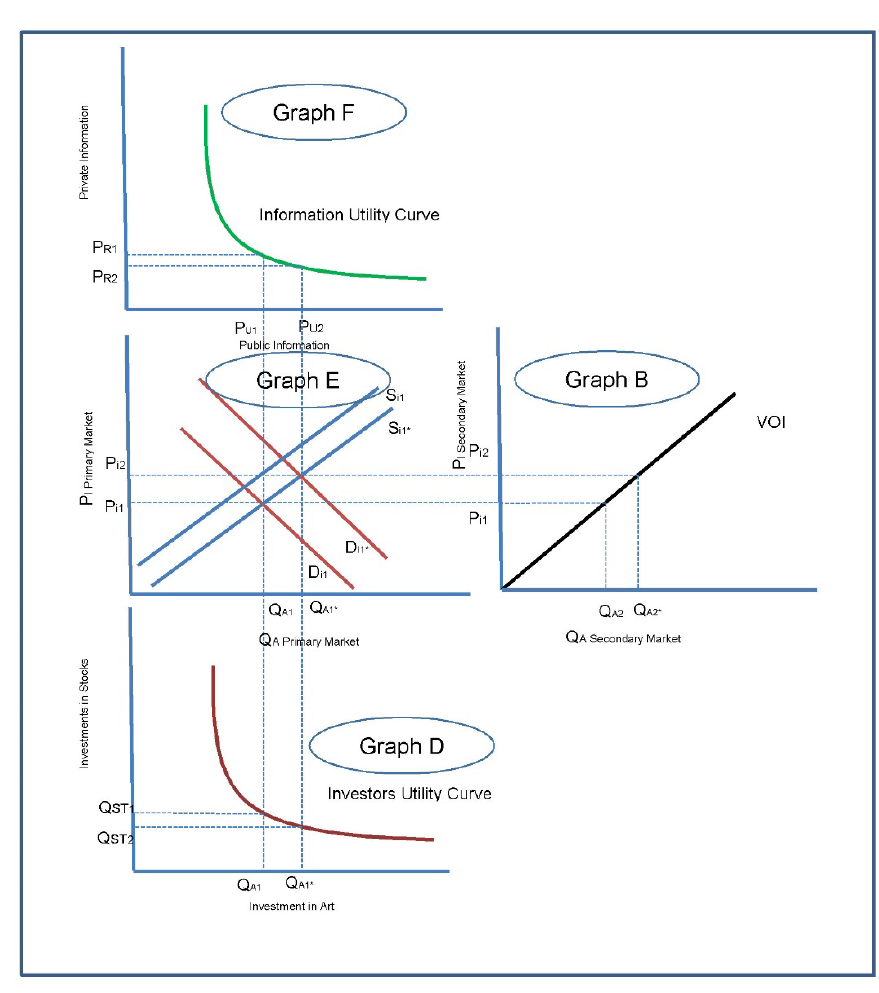
FIGURE 3: Transmission mechanism using 'Value of Information' from the primary market into the secondary market Source: Authors’